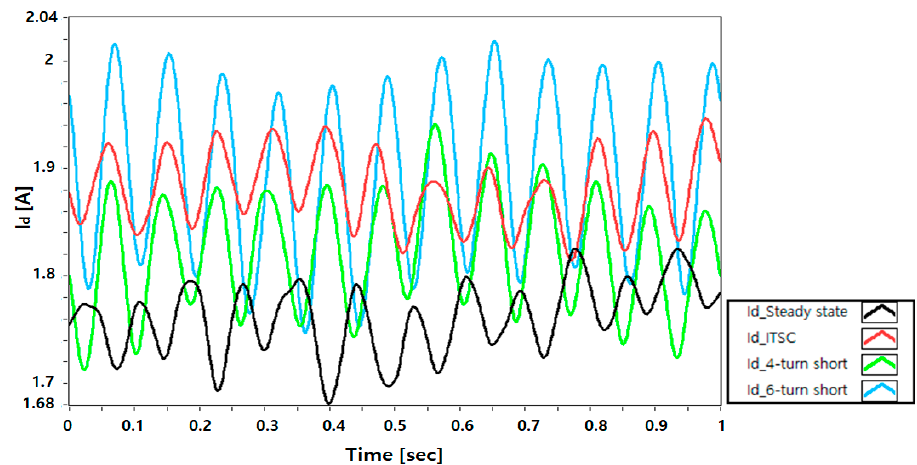
Figure 11. D-Q synchronous coordinate system during the full short turn.